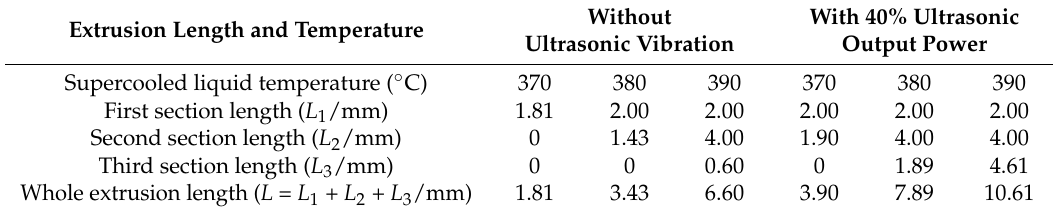
Figure 5. Ultrasonic microfilling length of Zr35 at different supercooled liquid temperatures: ( a ) microextrusion length ( L ); ( b ) equivalent extrusion length. Table 2. Extrusion length of Zr35 at different supercooled liquid temperatures.